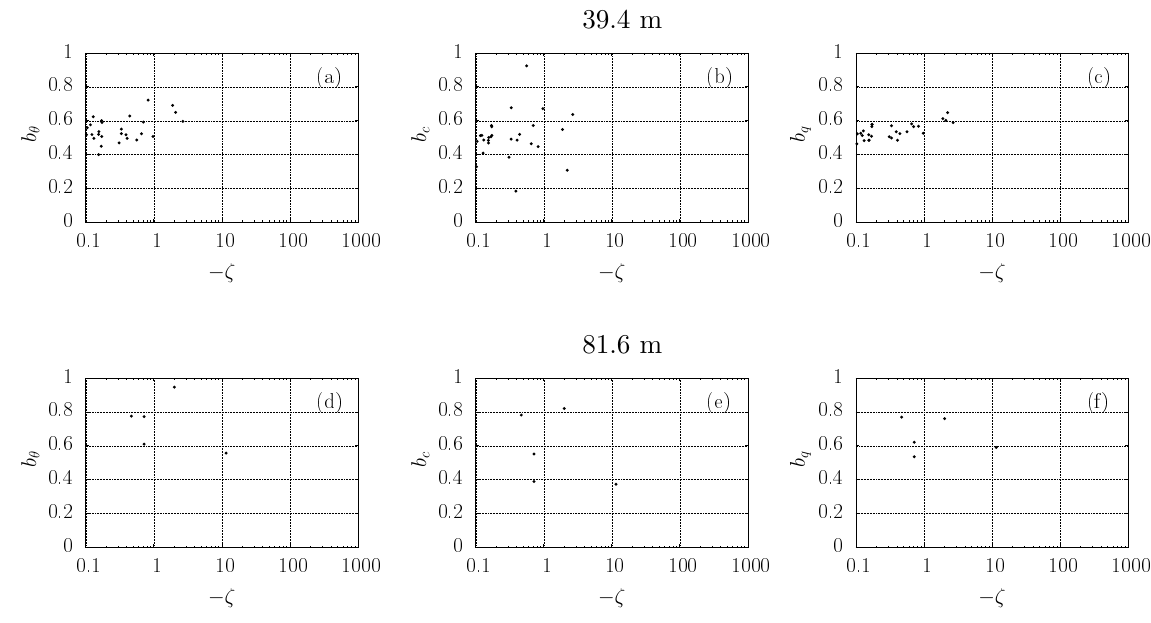
Figure 13. Relaxation coefficient variation with solar angle – 60 ◦ < | Z |≤ 90 ◦ . Panels (a, d) are temperature, (b, e) are CO 2 , and (c, f) are water vapor. Some data points were off the scale. Table 4. Statistics from REA for each zenith angle